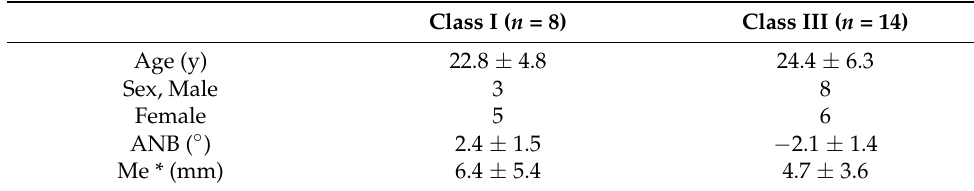
Table 1. Patient